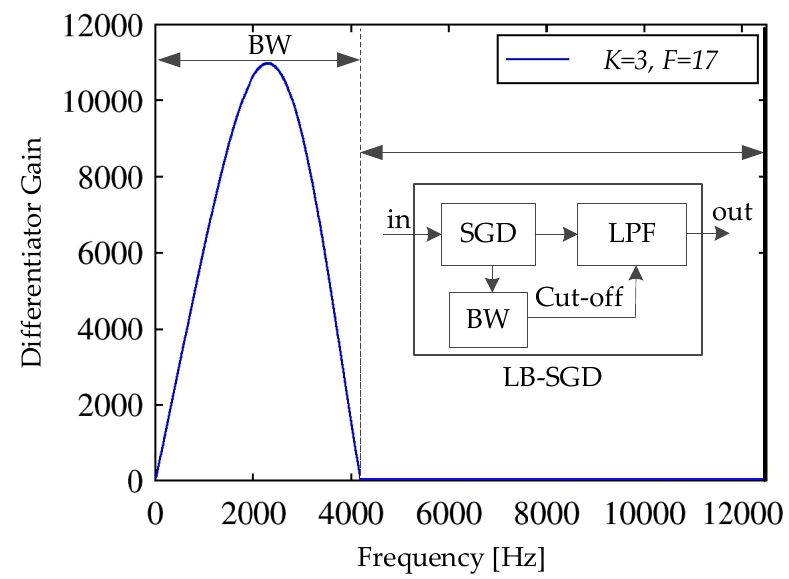
Figure 5. The signal flow of a MSGD and the subsequent frequency response.